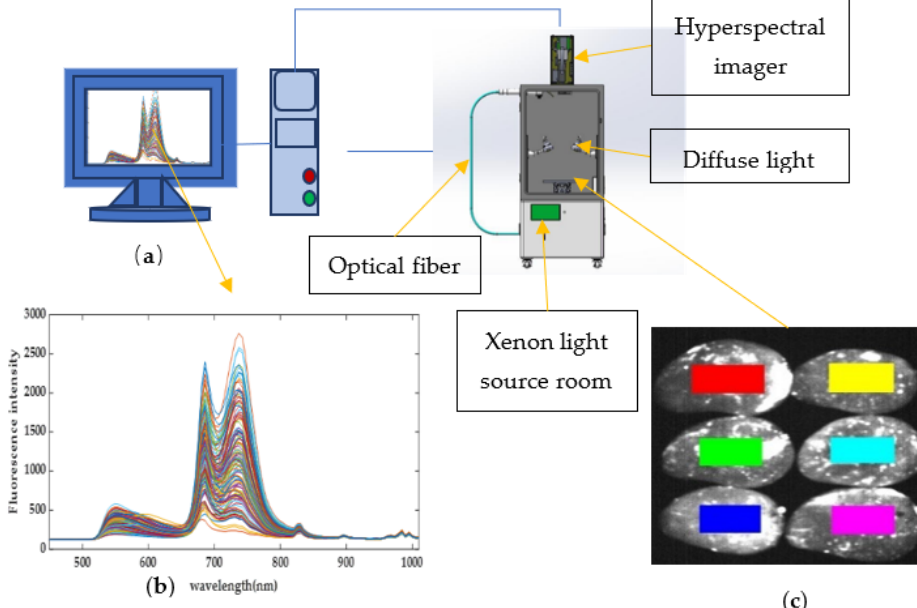
Figure 1. ( a ) Fluorescence hyperspectral system. ( b ) Raw hyperspectral fluorescent images. ( c ) Ex- traction of fluorescence spectra information of mango.